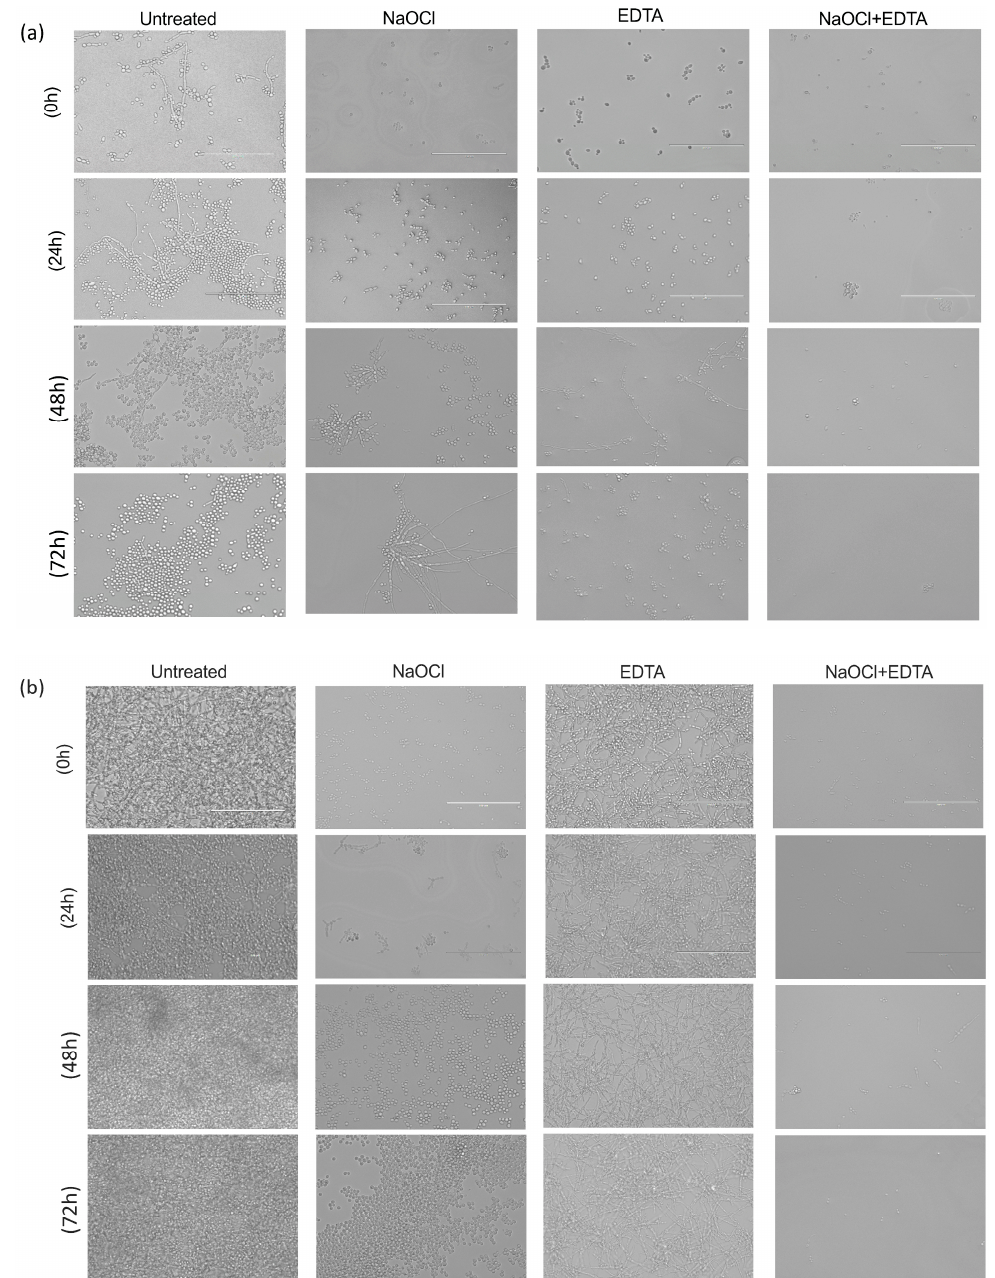
Figure 7. Microscopic examination of biofilms at four conditions: untreated, NaOCl, EDTA and NaOCl + EDTA treated biofilms. It demonstrates the biofilms at four time points, 0, 24, 48 and 72 h. ( a ) LBF ( b ) HBF. Bar is 40 µM for all panels.